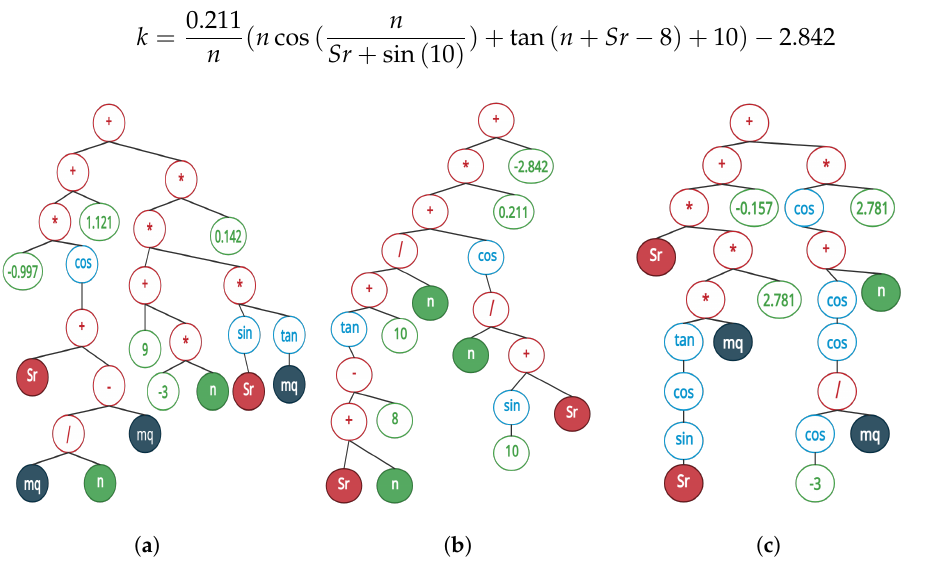
Figure 9. The GEP Expression tree from three configurations of input data: ( a ) expression tree for Network - I , ( b ) expression tree for Network - II , and ( c ) expression tree for Network - III